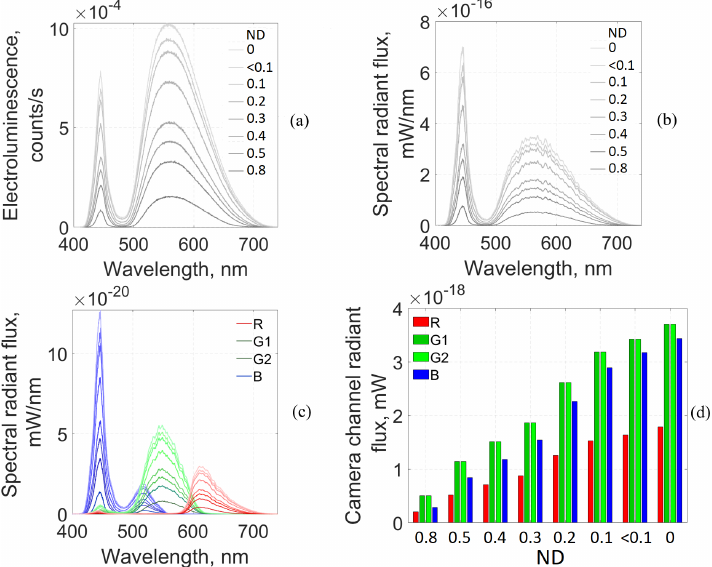
Figure 4. ( a ) The light spectra of gray filter coatings NDL–10S–4 ND 0.1–0.8, the blank silica support (ND < 0.1), and optical path without any absorber (ND 0) measured by a fiber spectrometer. ( b ) In- coming light spectra corrected to the fiber spectrophotometer spectral sensitivity. ( c ) The spectra of incoming light captured by the red (R), green (G1, G2) and blue (B) camera pixels. ( d ) Integral spectral values (radiant fluxes) reaching red, green, and blue camera pixels, respectively, after passing each neutral density ND